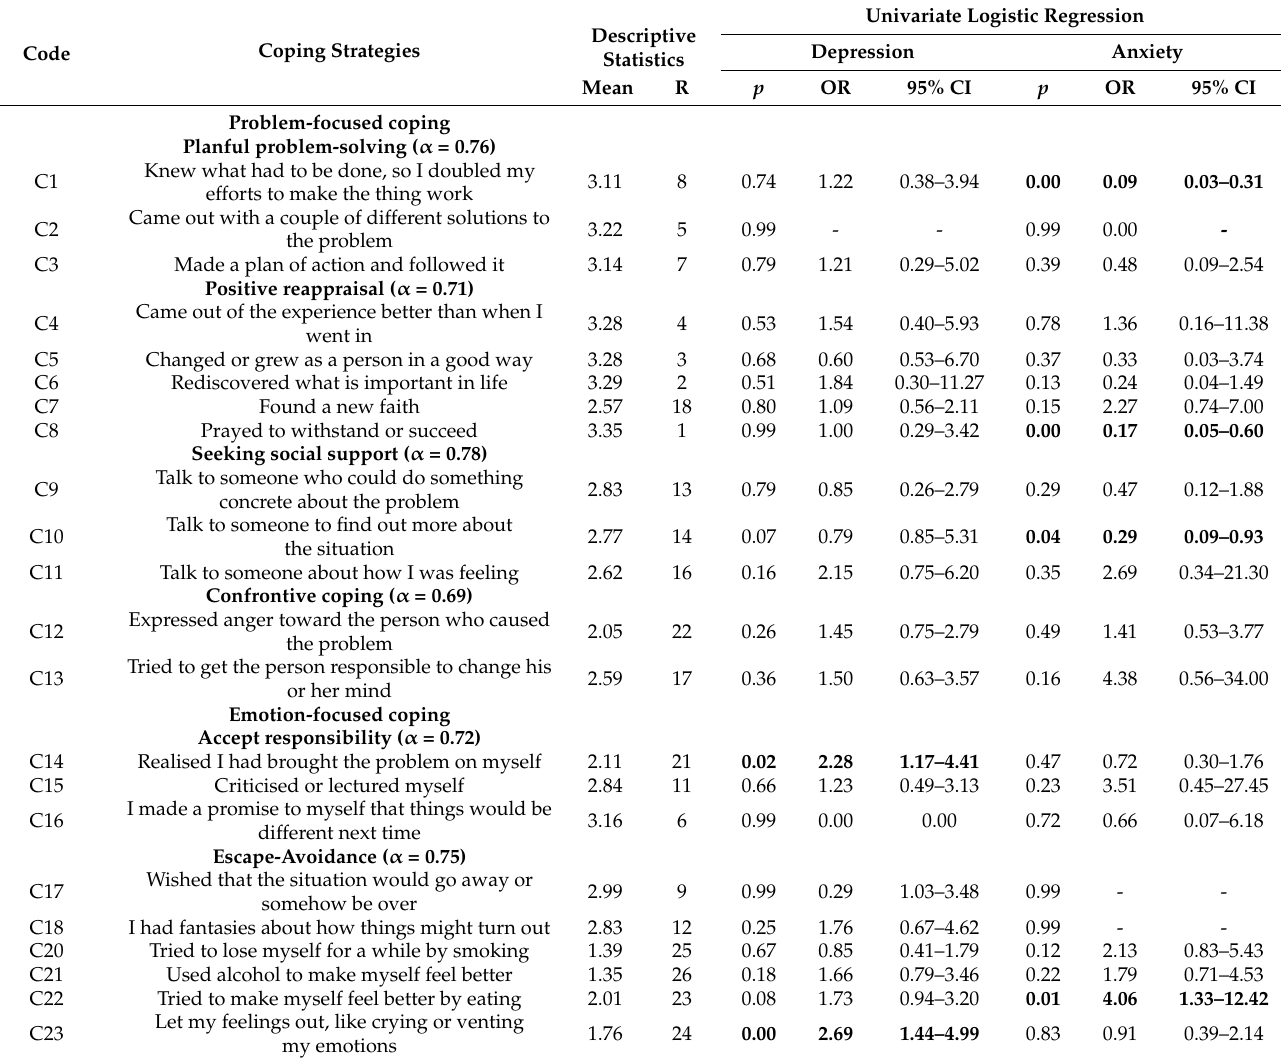
Table 4. Estimating the odds ratios for poor mental health in relation to coping strategies and mean score analysis of coping